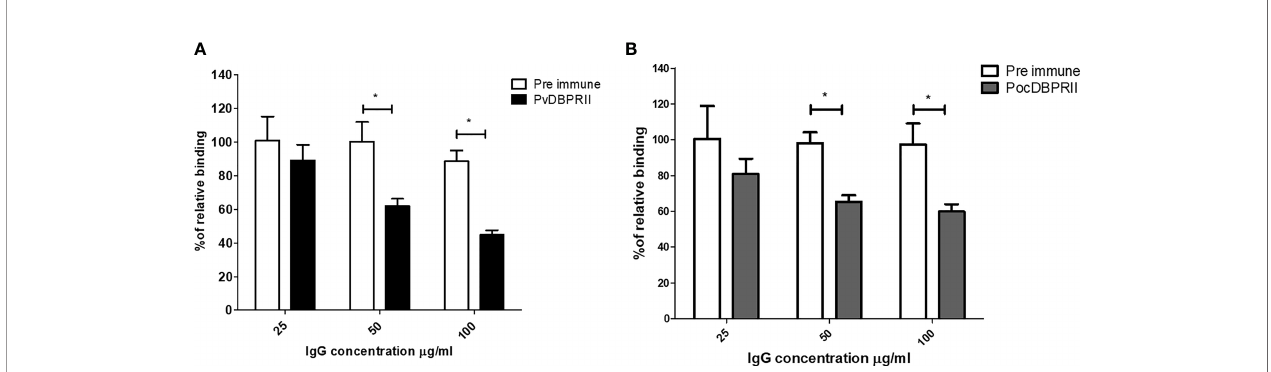
FIGURE 5 | Binding inhibition assay with the anti-PocDBP-RII antibody. Rabbit anti-PvDBP-RII (A) and anti-PocDBP-RII (B) antibodies were tested against homologous proteins in a fl ow cytometry binding assay for inhibition of PvDBP-RII and PocDBP-RII reticulocyte binding. Each bar represents the percent binding to